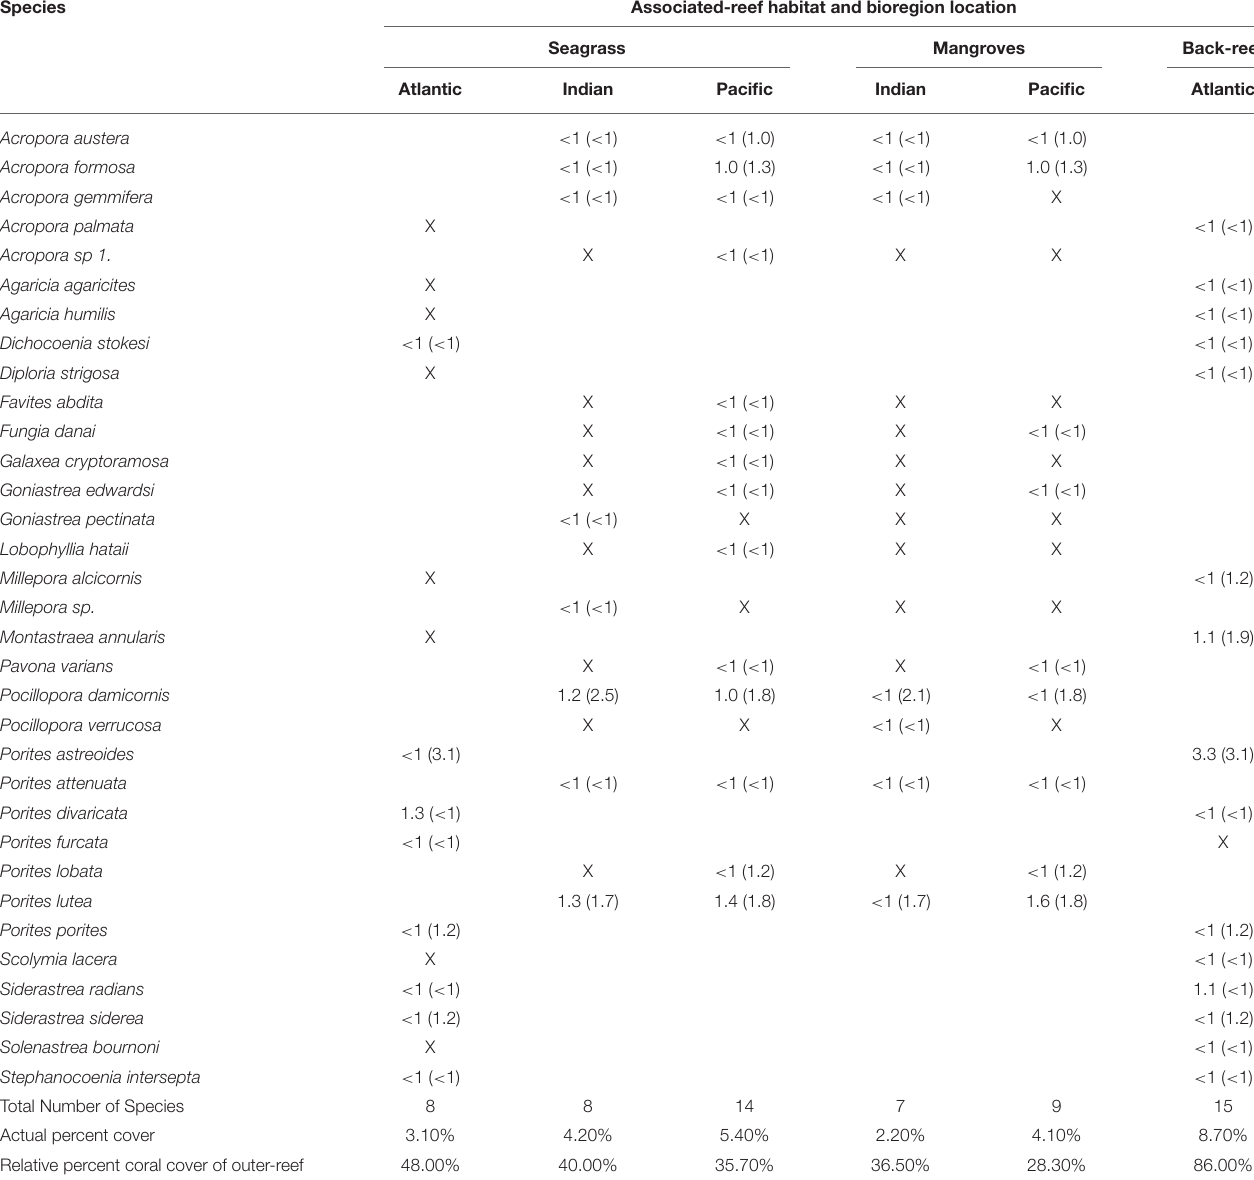
TABLE 3 | Coral species list for associated-reef habitat sites in the Atlantic, Indian, and Pacific Oceans.